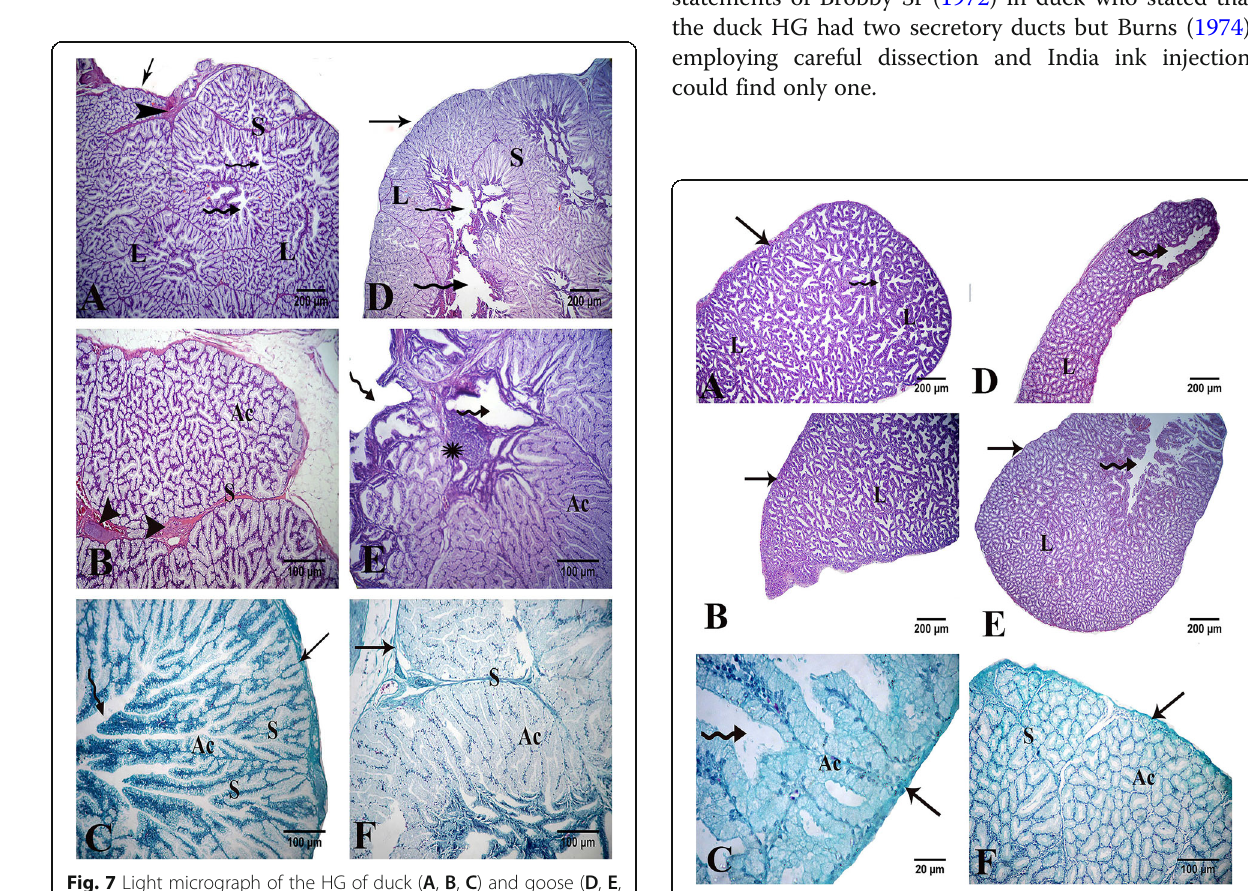
Fig. 8 Light micrograph of the HG of ibis ( A , B , C ) and pigeon ( D , E , F ) showed the lobules (L) formed from secretory acini (Ac) and covered by capsule (arrow), septa (S), and irregular lumen of duct (zigzag arrow). Note the broad extremity of the gland in A and E and pointed extremity in B and D . Stain, H&E in A , B , D , and E and Masson trichrome in C and